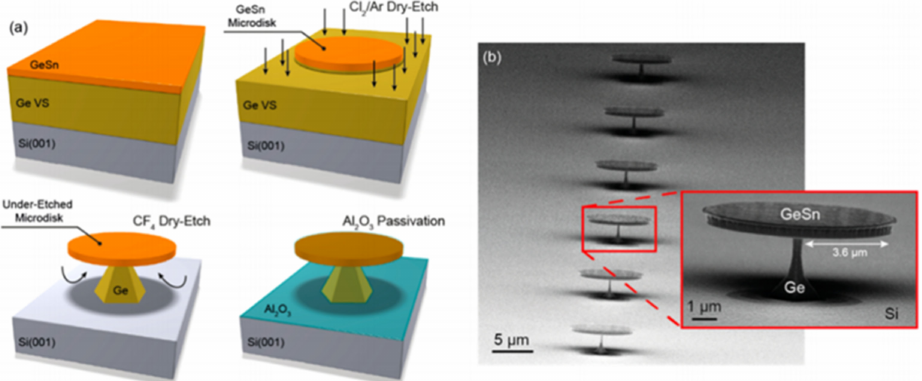
Figure 29. ( a ) Process flow for GeSn microdisk; ( b ) SEM image of GeSn microdisk with an Sn content of 12.5% (diameter was 8 µ m). Reproduced with permission from [74], American Chemical Society, 2016.